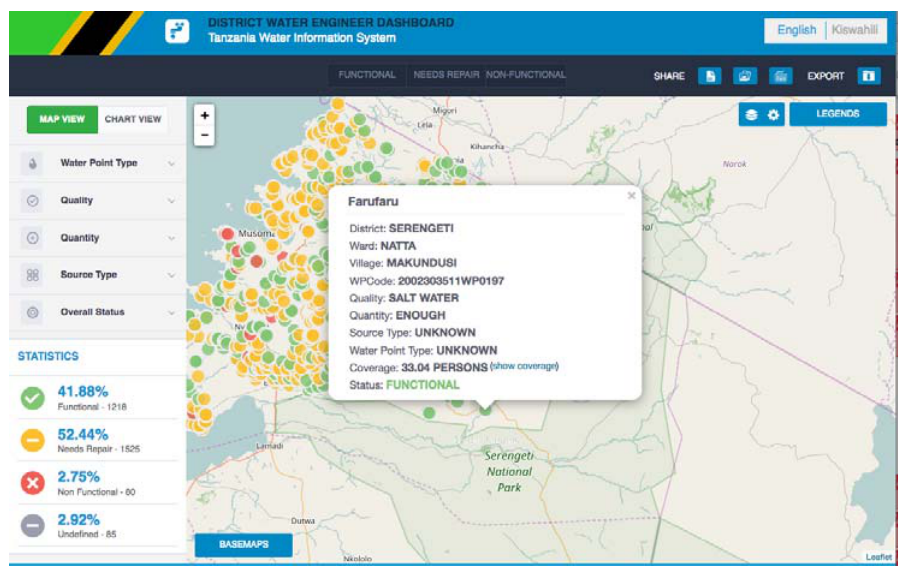
Figure 4. DWE responsive dashboard for Smartphones and Desktops.